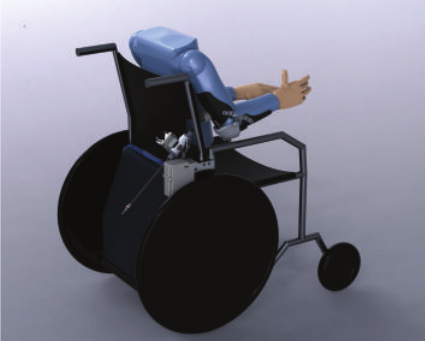
Figure 1: CAD model of the OrthoJacket.